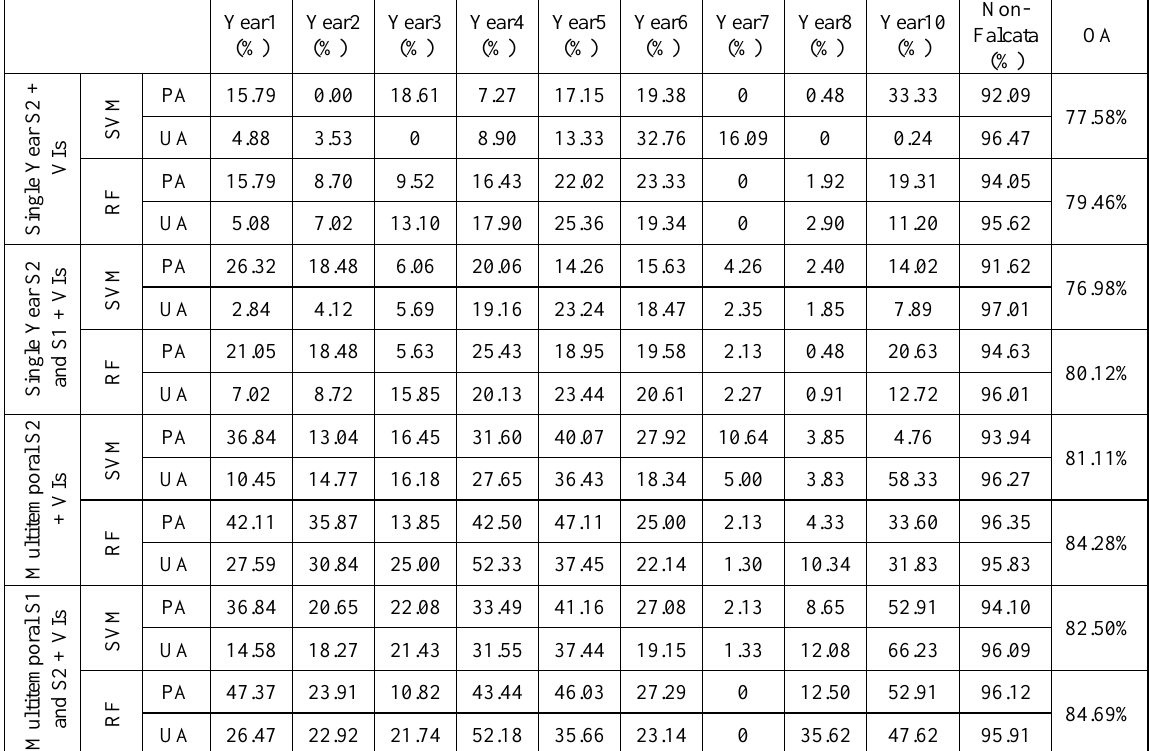
Table 5. Accuracies of the machine learning classification-based Falcata stand age